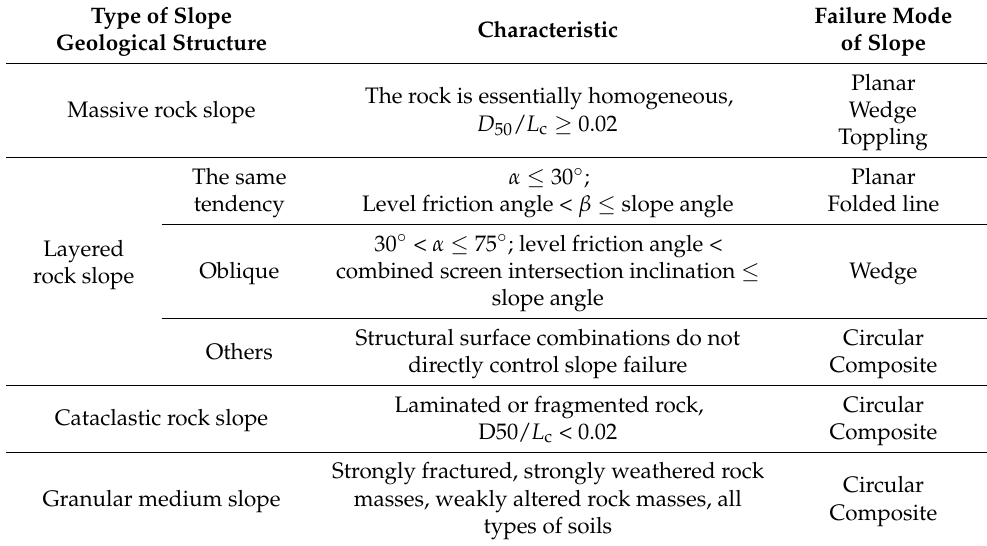
Table 5. Geological classification of slopes in open-pit